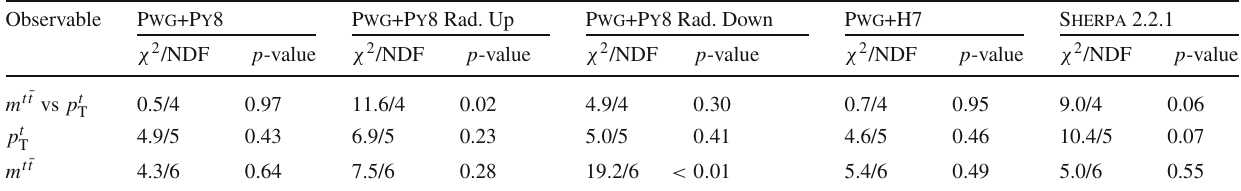
Table 25 Comparison of the measured parton-level normalised differ- ential cross-sections in the boosted topology with the predictions from several MC generators. For each prediction a χ 2 and a p -value are